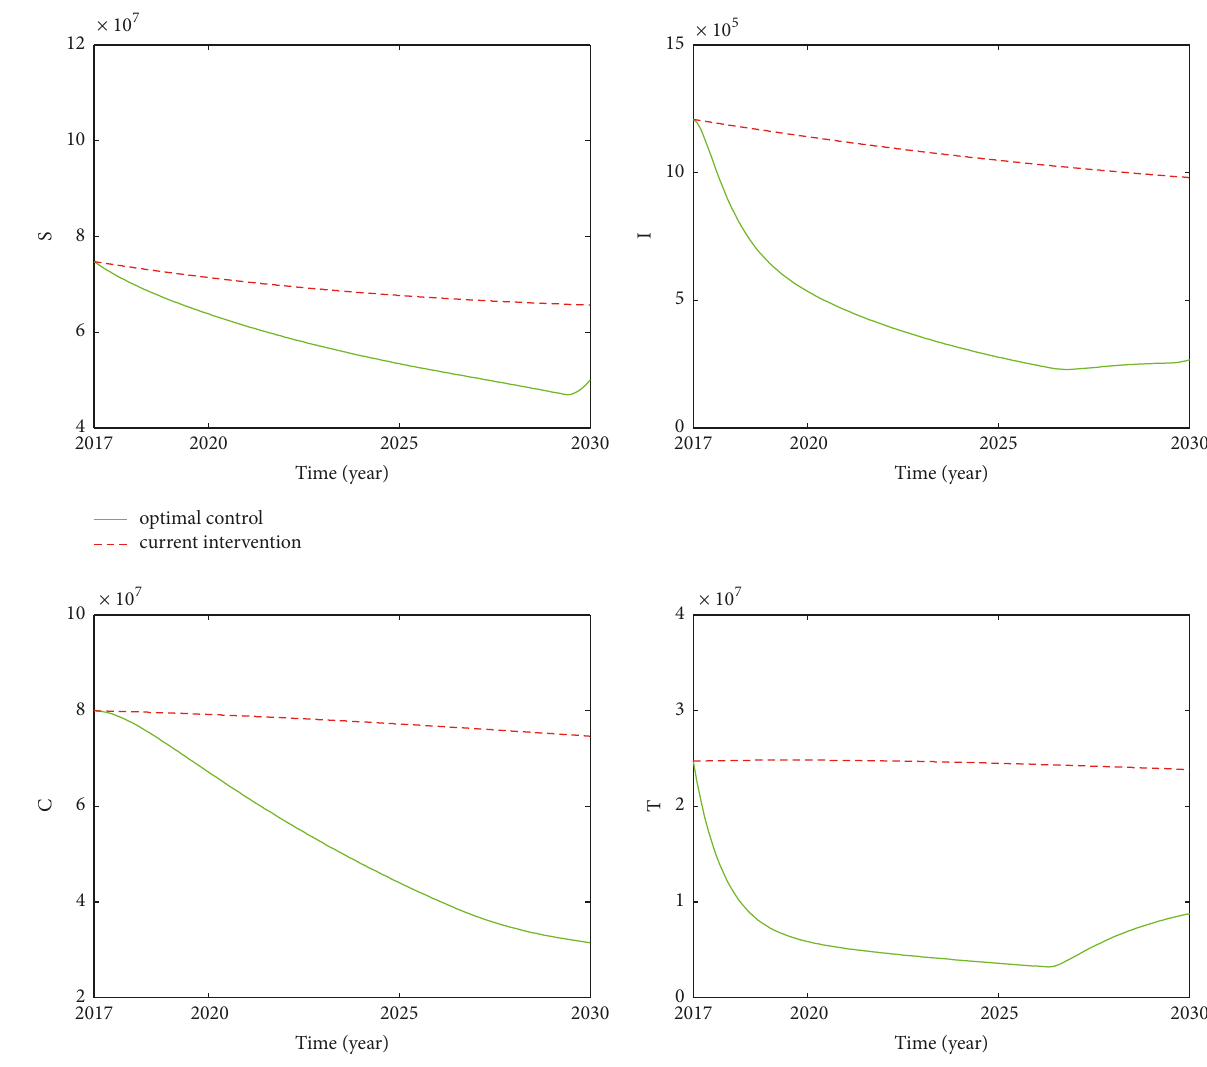
Figure 6: Optimal states for (18) plotted as time evolves. Dashed lines present the simulations with optimal control 𝑢 ∗ and solid lines present that with current interventions in China, with the same parameters as in Figure 4 and R 0 = 1.0764